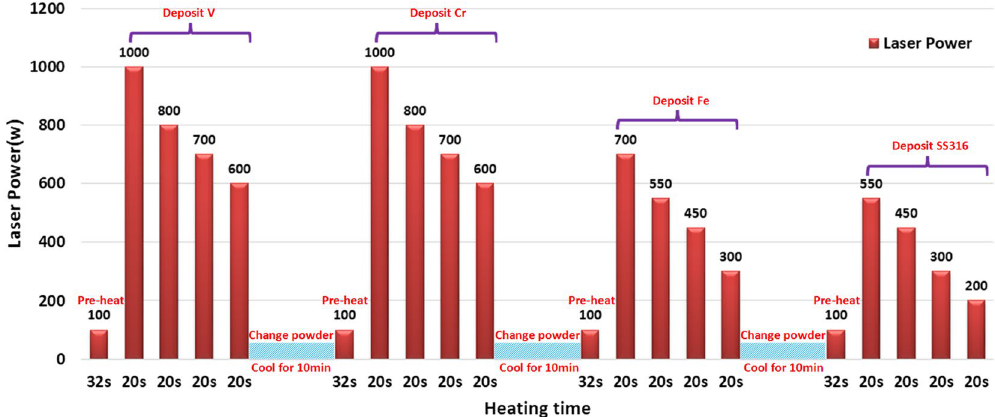
Figure 18. Thermal history in whole 3D printing